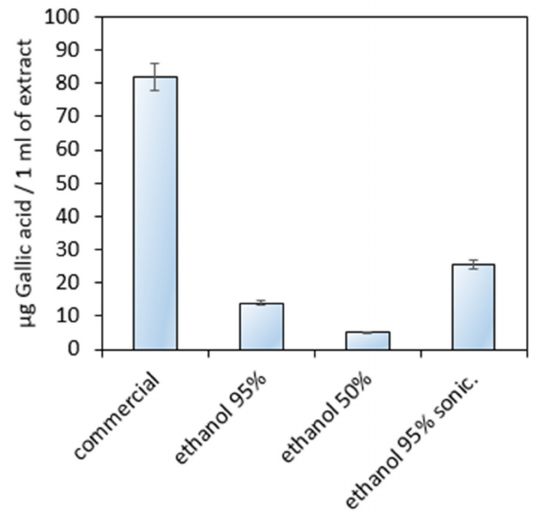
Figure 6. Phenols and polyphenols content investigation using Folin–Ciocalteu